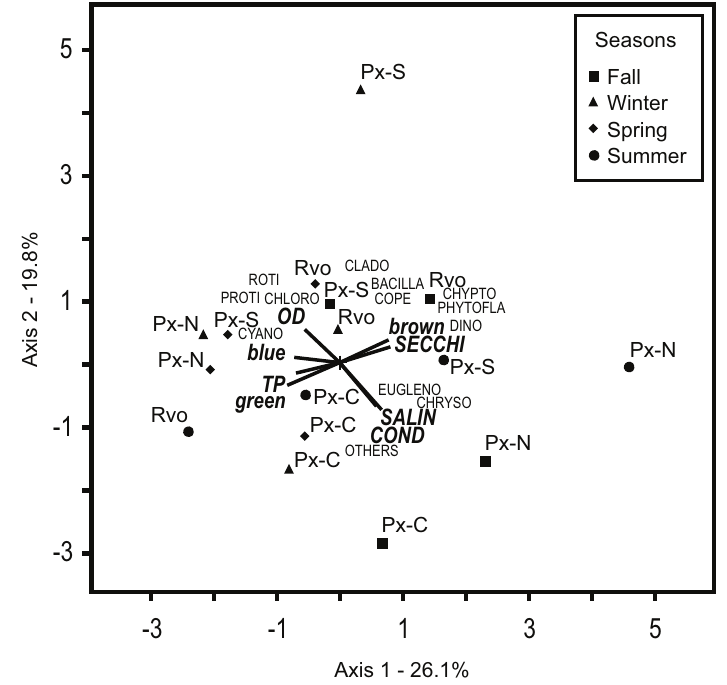
Figure 9 - Redundancy Analysis (RDA) Ordination plot of seasonal density of planktonic groups in the Ruivo and Peixe lagoons (Legend for locations and variables see Table I; BACILLA = Bacillariophyceae, CHLORO = Chlorophyceae, CRYPTO = Cryptophyceae, CHRYSO = Chrysophyceae, CYANO = Cyanophyceae, DINO = Dinophyceae, EUGLENO = Euglenophyceae, PHYTOFLA = Phyto fl agellates, PROTI = Protista, ROTI = Rotifera, CLADO = Cladocera, COPE = Copepoda, OTHERS = refers to larval stages and other marine zooplankton groups such as foraminifera).